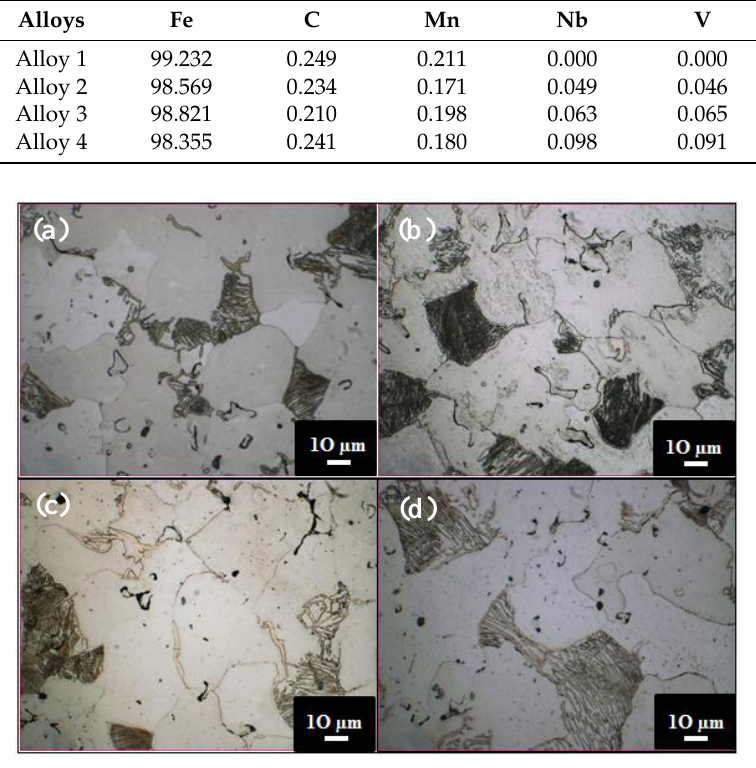
Figure 3. Micrographs of non-alloyed PM steel specimens of Fe+0.25C sintered at various temperatures